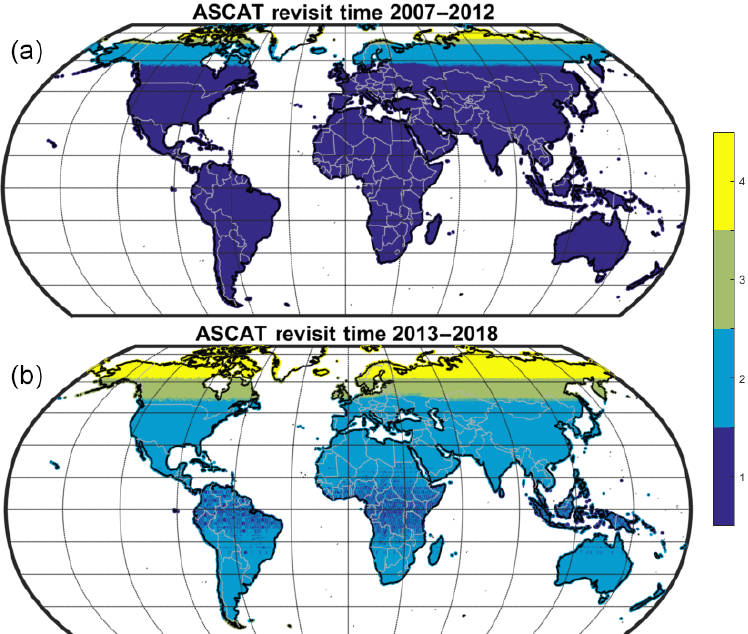
Figure A1. Mean daily revisit time (d) of ASCAT soil moisture observations for the period 2007–2012 (only MetOp-A, a ) and for the period 2013–2018 (MetOp-A and MetOp-B, b ).